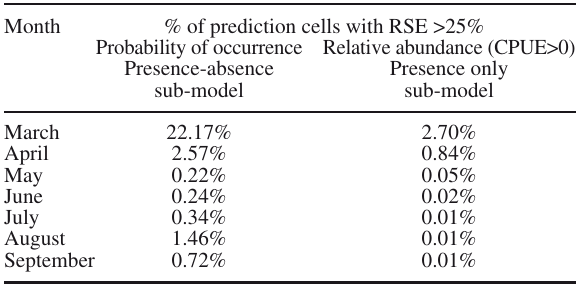
Fig . 2. – Generalized additive model (GAM) derived effects of the investigated parameters on the Delta-binomial probability of encountering a bluefin tuna school (presence-absence sub-model). Shaded areas indicate two standard errors above and below the estimates. Relative density of data points is shown by the ‘rug’ on the x-axis. Table 6. – Proportions of relative standard errors (RSE) above 25% for the monthly prediction